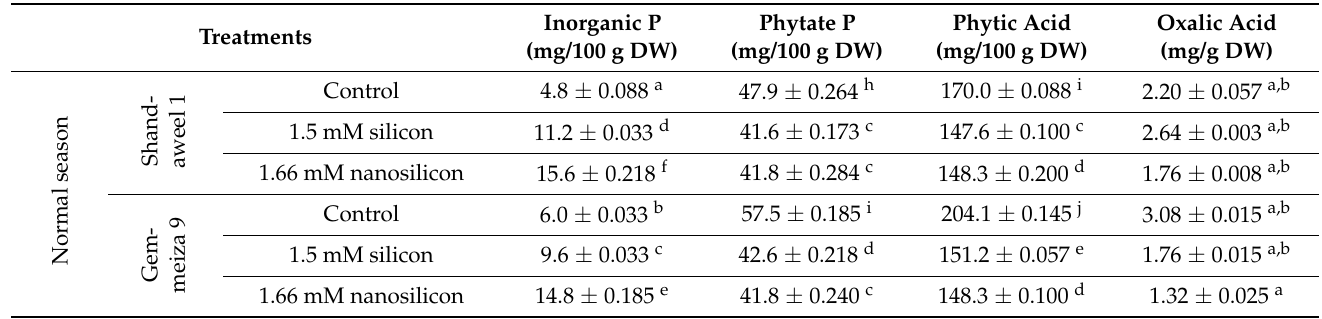
Table 6. Effects of silicon and nanosilicon on inorganic phosphorous, phytate P, phytic acid and oxalic acid contents in grains of two wheat cv. Shandaweel 1 and cv. Gemmeiza 9 at normal and late seasons. Each value is the main of three different replicates ±